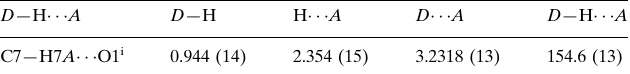
Hydrogen-bond geometry (A˚ , (cid:2)